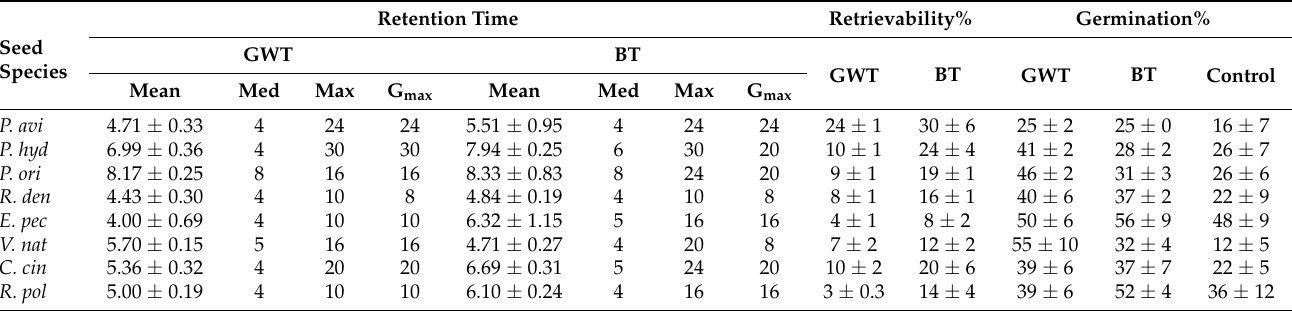
P. avi: Polygonum aviculare, P. hyd: Polygonum hydropiper, P. ori: Polygonum orientale, R. den: Rumex dentatus, E. pec: Euphrasia pectinate, V. nat: Vallisneria natans, C. cin: Carex cinerascen, R. pol: Ranunculus polii .